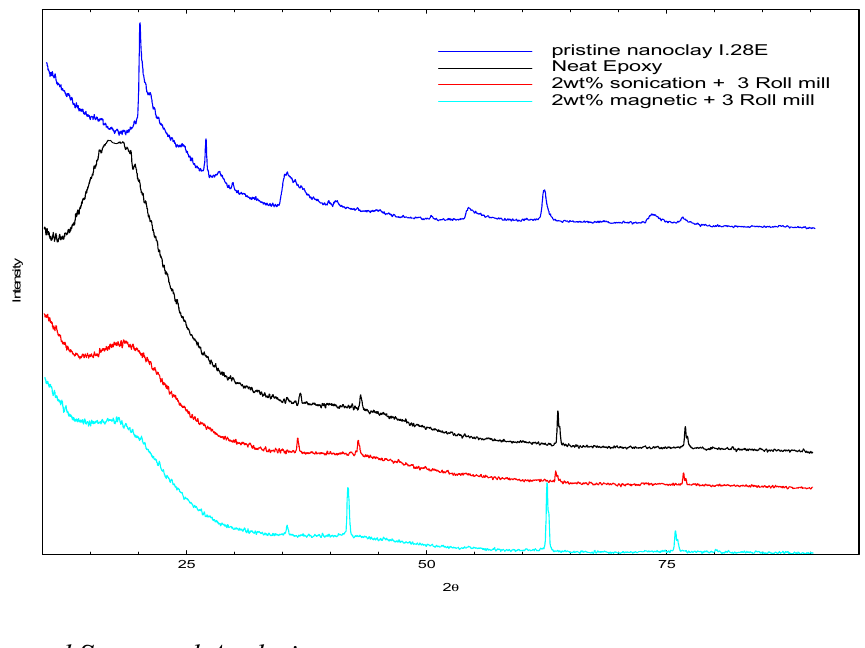
Figure 2. X-ray diffraction for pristine nanoclay, neat epoxy and nanocomposite polymer of 2 wt.% for sonication and magnetic mixing